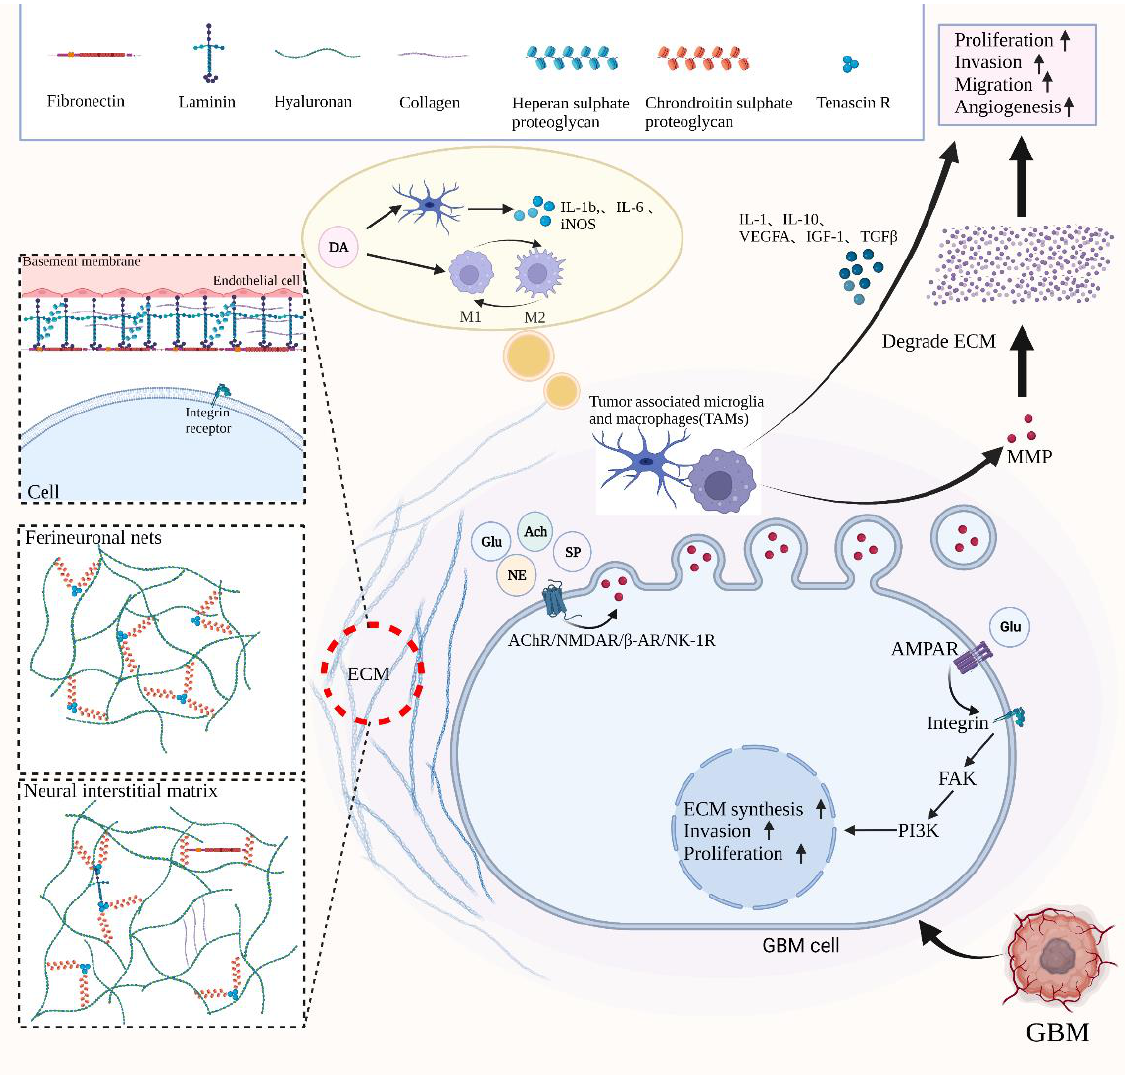
Figure 2. The role of neurotransmitters in regulating infiltrative capacity of GBM. Neurotransmit- ters, such as ACh, Glu, NE and SP, regulate invasion behavior of GBM by affecting the activation of matrix metalloproteinases (MMPs). MMPs are a group of proteolytic enzymes secreted by cancer